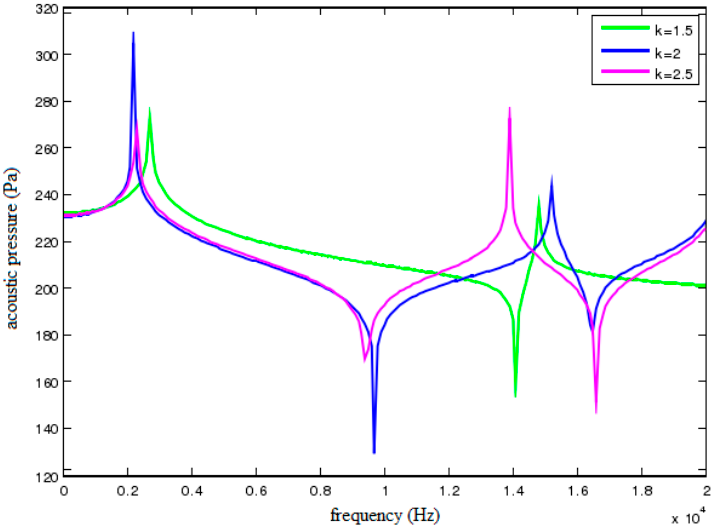
Figure 13. Acoustic pressure characteristic curves of field point A under different gap widths.